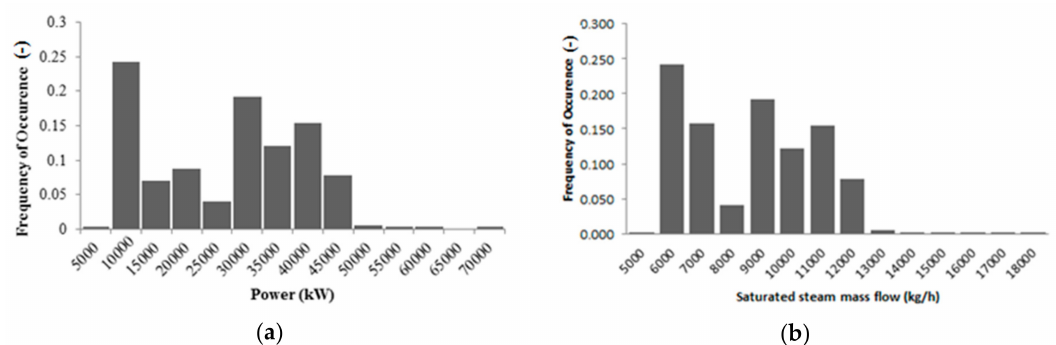
Figure 5. Cruise ship operating profiles; ( a ) Total power (for propulsion and hotel load) demand; ( b ) Saturated steam demand adapted from [41].